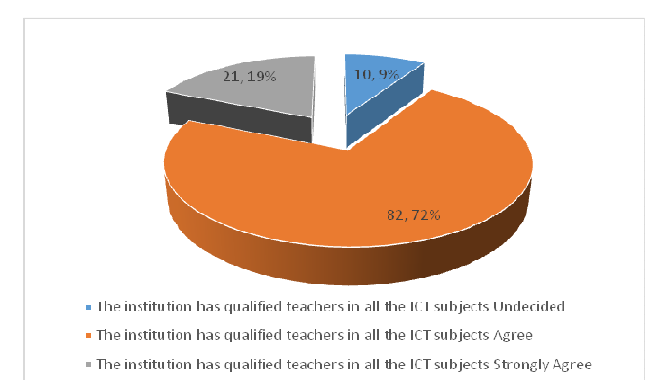
Figure 1: The institution has qualified teachers in all the ICT subjects Source: Author Data (2015)